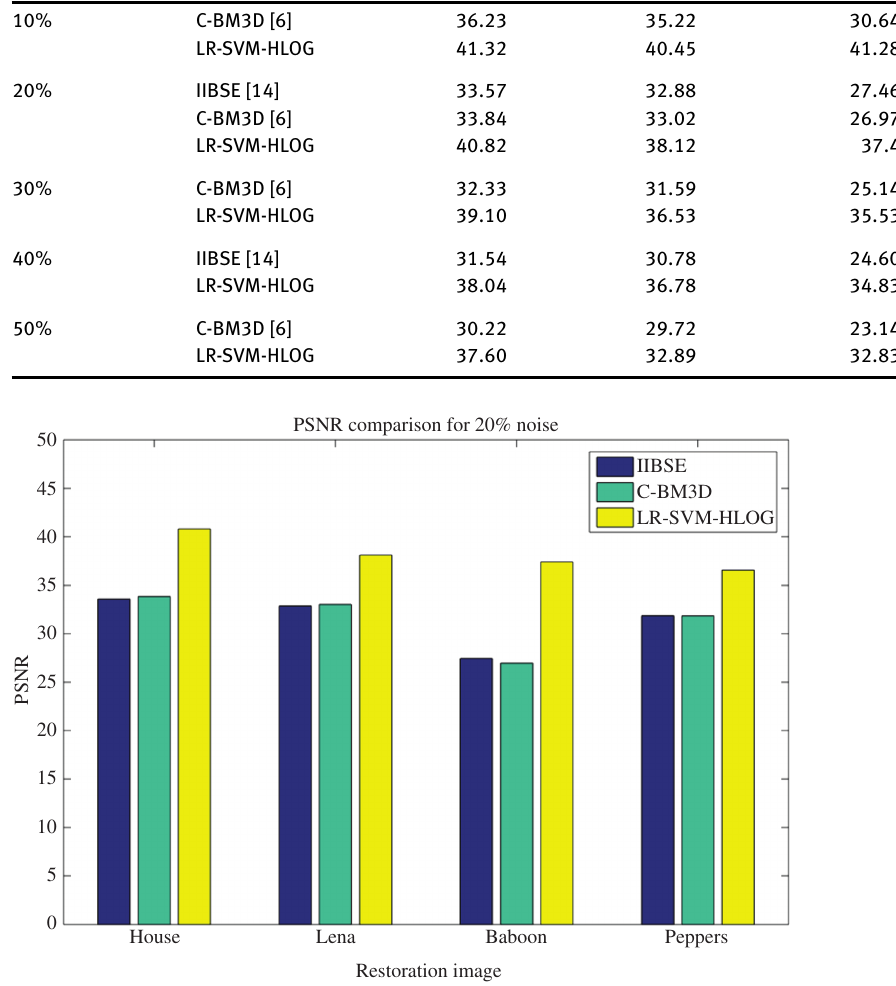
Figure 11: Comparative Analysis of Color Images for LR-SVM-HLOG with Existing Methodologies in 20% Noise